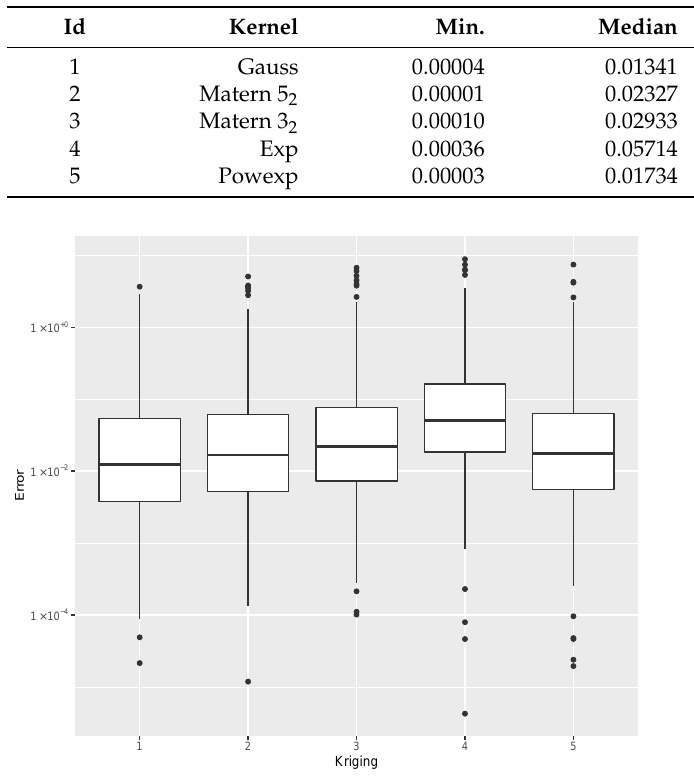
Figure 8. Error dispersion of the b I estimate using distinct Kriging kernel options. The minimum error, the median error, and the maximum error in the estimation of the mass m are shown in Table 5. The error dispersion of the mass estimates using all Kriging methods are compared in Figure 9, where the first model, based on the Gauss kernel, is the best mass predictor according to the metric of the median error. Table 5. Error statistics of the mass estimate using a distinct Kriging covariance kernel structure.